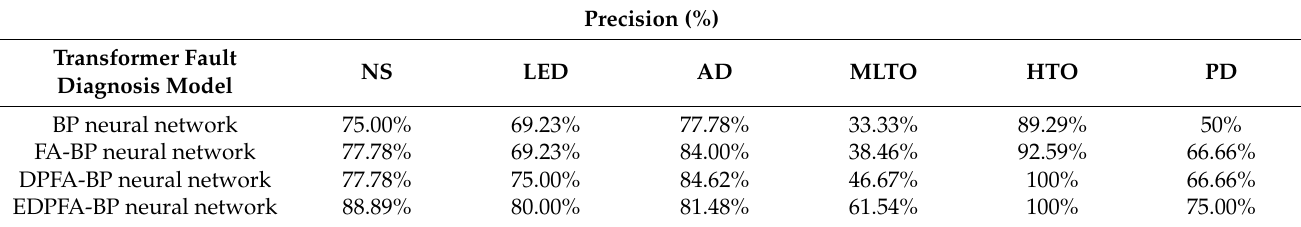
Table 10. The precision of each